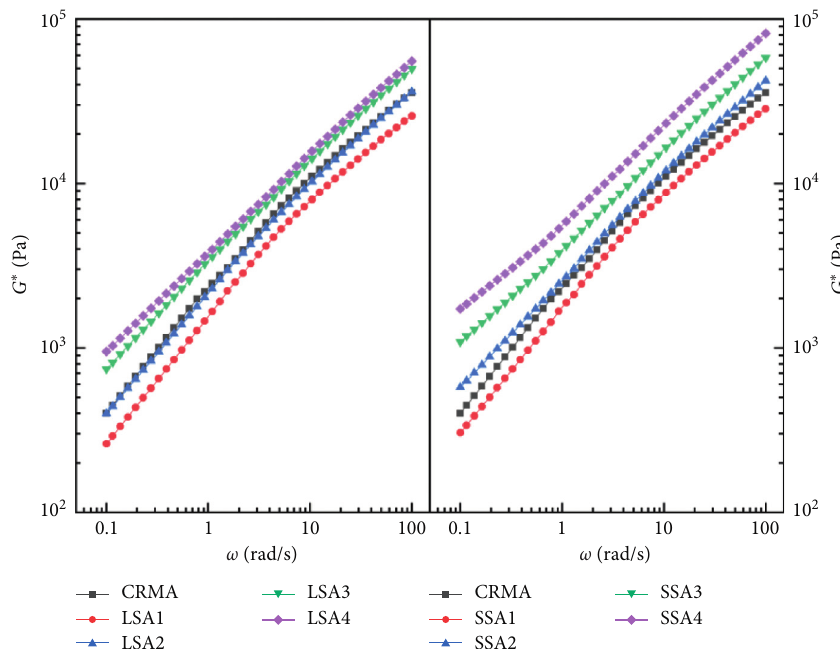
Figure 7: Variation of G ∗ with the SBS contents for modified asphalts.